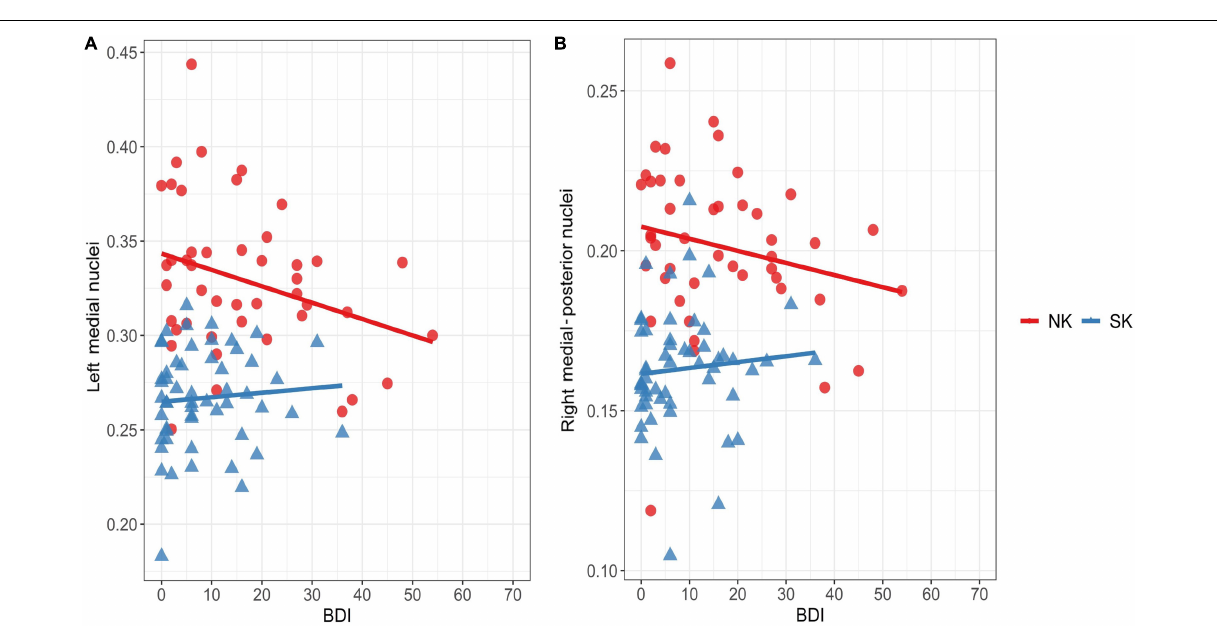
FIGURE 4 | Correlations between depressive symptoms and thalamic areas showing increased gray matter volume in the NK refugees (red) SK residents (blue). Correlations are shown between the BDI score and gray matter volume ratio in the left medial nuclei (A) and right medial-posterior nuclei (B) is shown above. In the NK refugees alone, gray matter volume ratios in the left medial nuclei ( r = –0.43, p = 0.009) and right medial-posterior nuclei ( r = –0.33, p = 0.049) were negatively correlated with the BDI score after adjustment for age, sex, and the number of traumatic experiences. NK, North Korean; SK, South Korean; BDI, Beck Depression